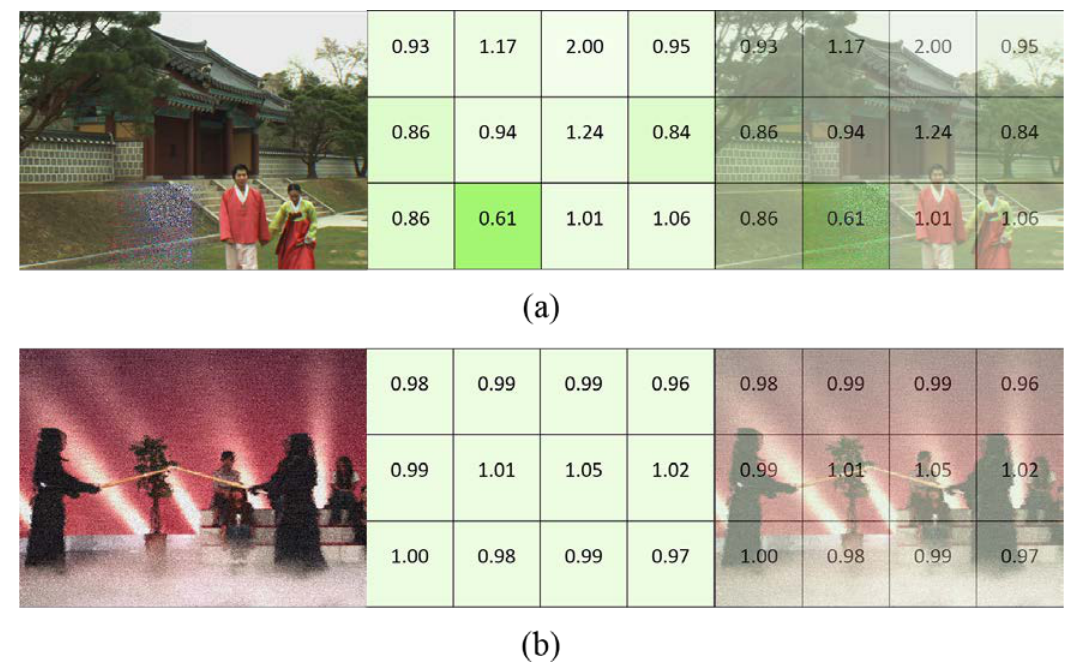
Figure 5. Visualization of HDP weights. The left image is a distorted image, the middle image is an HDP weight map, and the right image is an intuitive comparison of the distorted image and the HDP weight map: ( a ) case of local distortion; ( b ) case of global distortion.